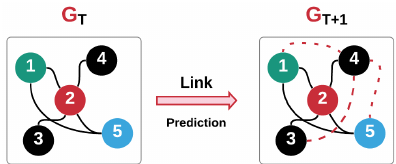
Figure 7. Non-Priodic link prediction: The input is just a snapshot of current